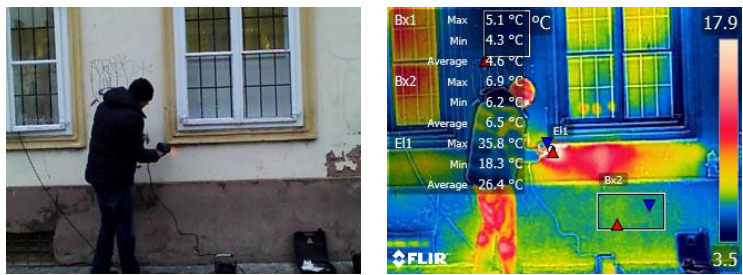
Figure 22. Increasing the area of applied thermal excitation.